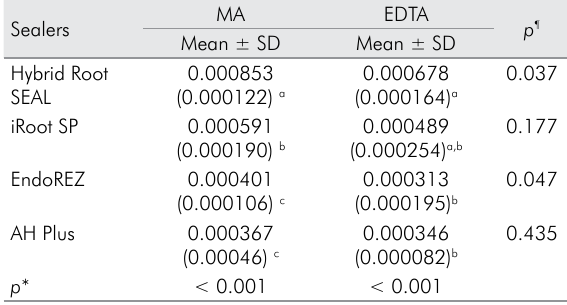
Table 1. Means and standard deviations of the microleakage